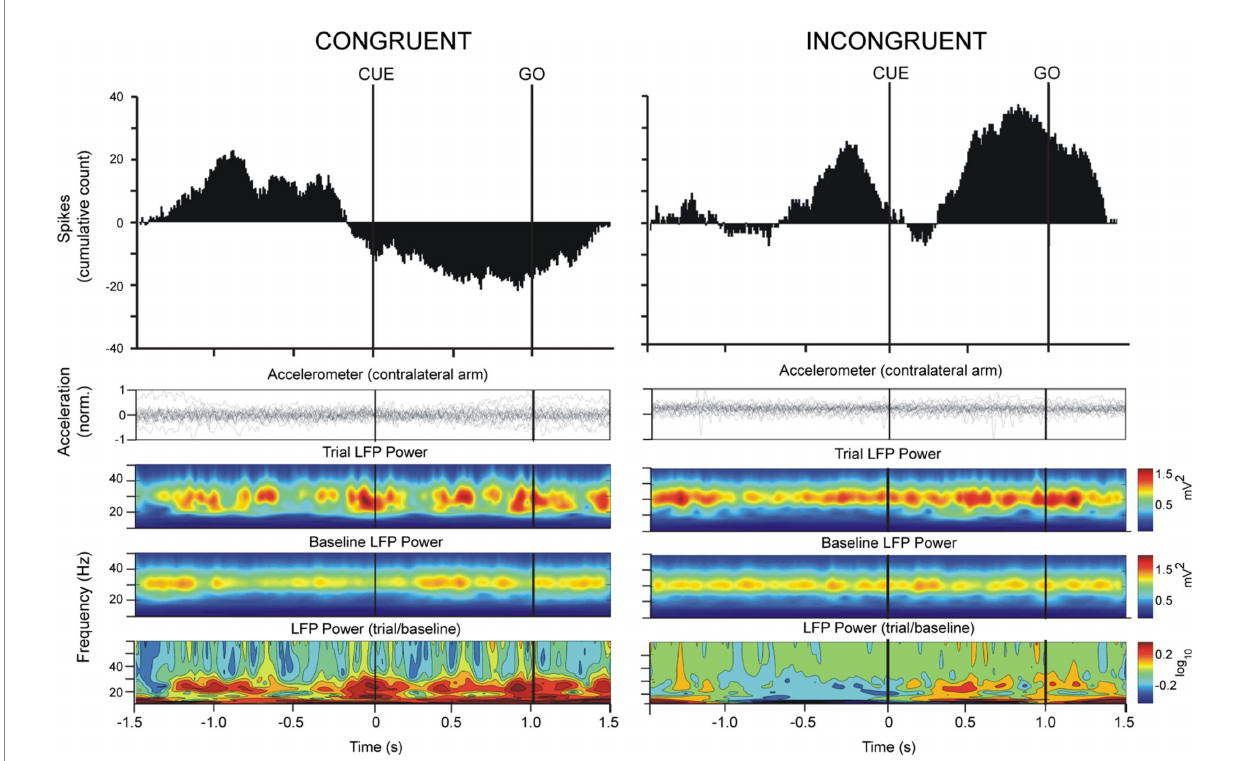
FIGURE 3 Simultaneously recorded spike and LFP data from 20 trials in an ET patient were averaged with respect to the CUE and GO triggers in congruent and incongruent paradigms. The top trace shows the cumulative sum of spiking activity of the Vim neuron and accelerometer traces are shown second from the top. The “trial LFP power” spectrogram shows average LFP power (filtered 13–30 Hz) from 20 trials referenced to the CUE trigger. The “baseline LFP power” plot was obtained by assigning 20 random triggers in the recording file and averaging the data over this trigger. The “LFP power (trial/baseline)” plot is the ratio of movement-related frequency-power changes to the baseline frequency power. Note that the power scale of the ratio is logarithmic such that a 0.1 increment reflects an increase by 25% of movement-related beta power in relation to baseline. During the performance of the center-out task in the congruent orientation, the increase of beta power during the preparatory phase occurred concomitantly with a decrease in neuronal firing of the Vim